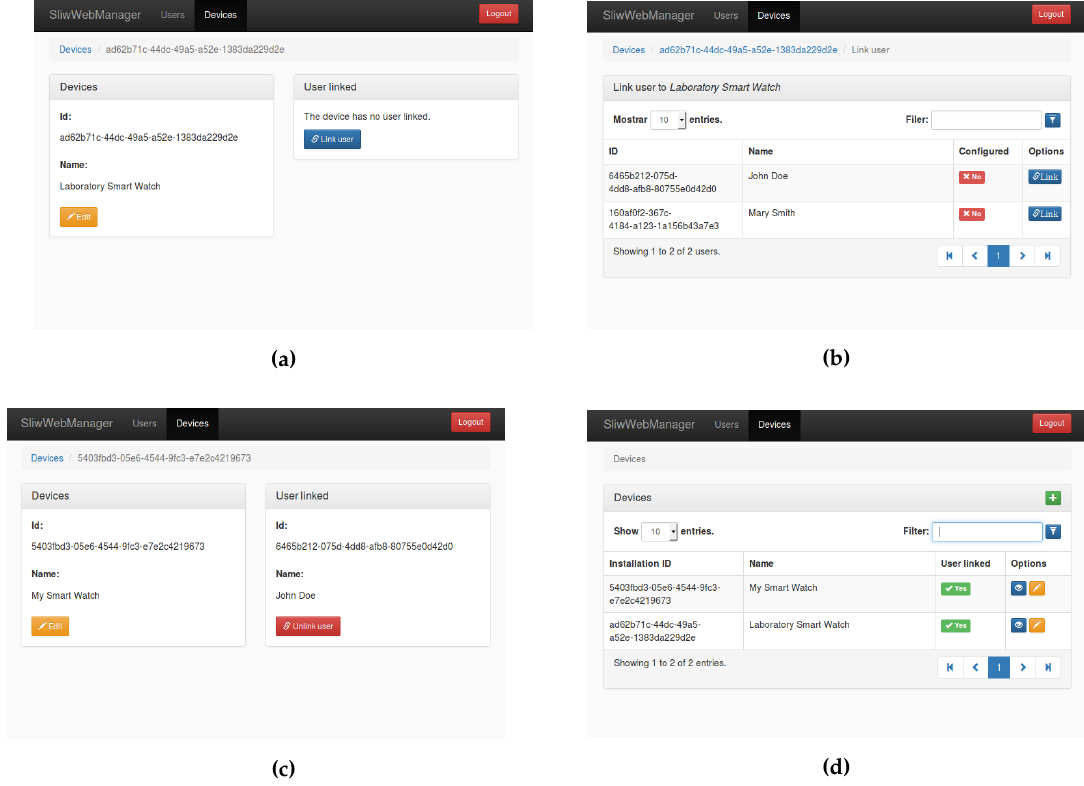
Figure 5. Process for linking a device to a user. ( a ) Setting up a new link; ( b ) Selecting a user to be linked to a device; ( c ) User already linked; ( d ) Device showing that a user is linked to